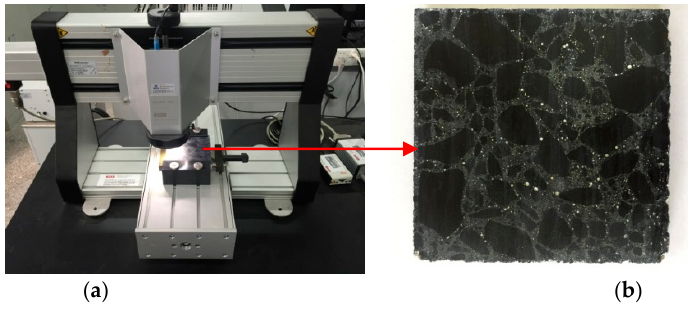
Figure 2. ( a ) Test instrument. ( b ) Test specimen.